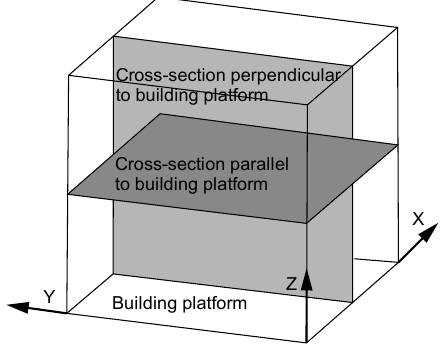
Figure 10. View of the element characteristic zones.